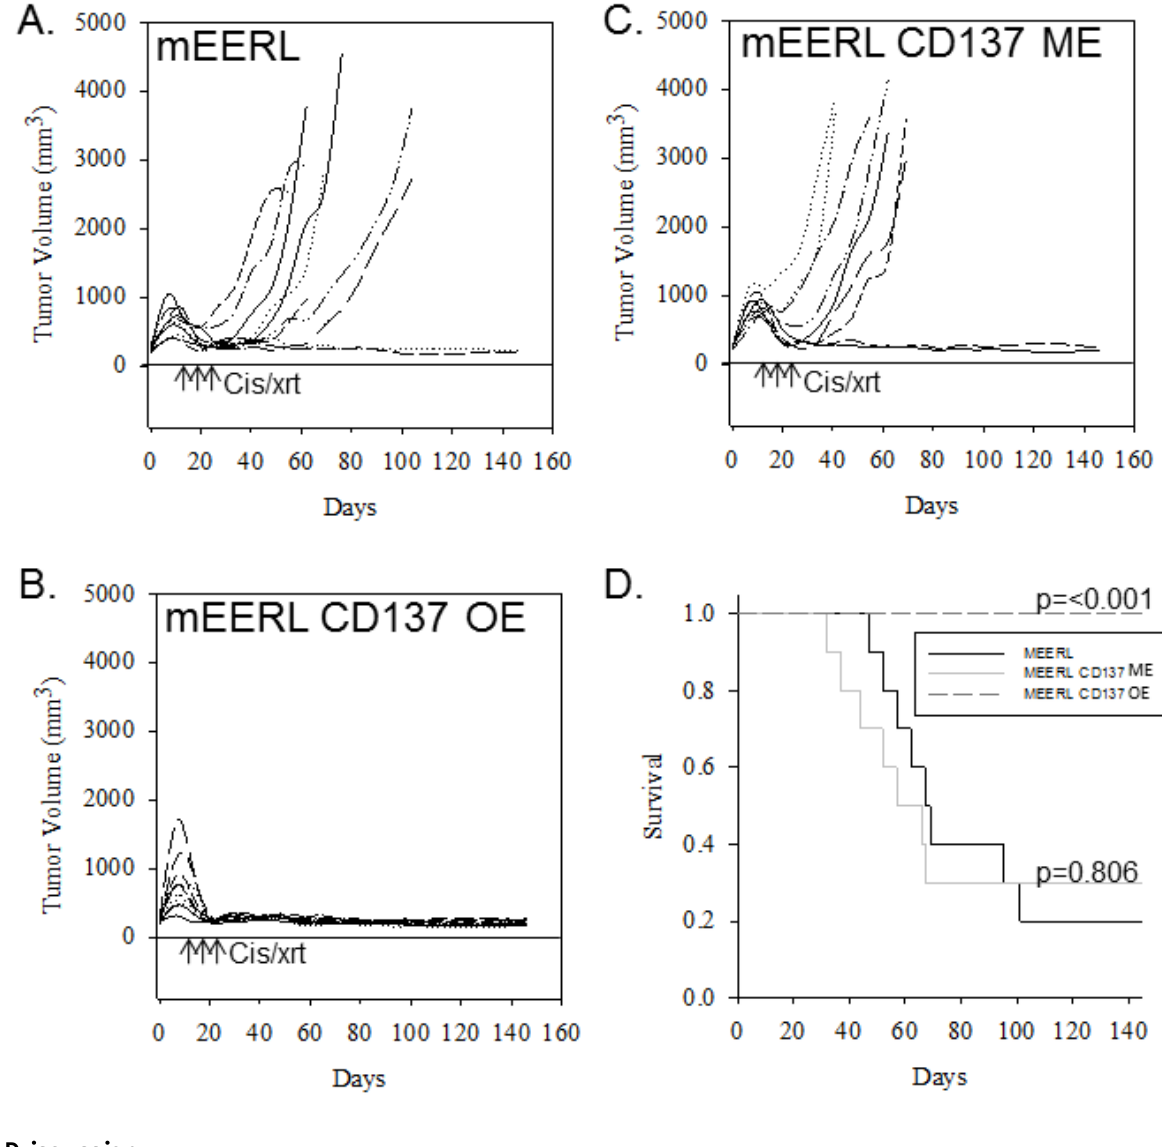
Figure 4. Over-expression of CD137L on tumor cells enhances anti-tumor effects of CRT. Tumor growth curves (for individual mice) and group Kaplan-Meier survival curves are shown for mice implanted with ( A ) parental mEERLs, ( B ) mEERLs over-expressing CD137L (OE), or ( C ) mEERLs minimally expressing CD137L (ME). Mice received three doses of cisplatin (20 mg/kg) and radiation (8 Gy) on indicated days (arrows), ( D ) Kaplan-Meier survival curves for mice in A, B and